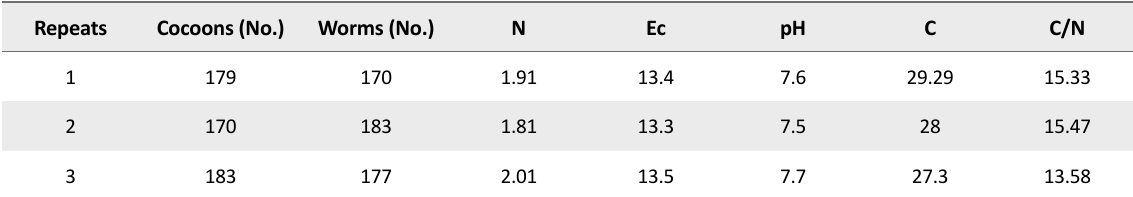
Table 1. Qualitative characteristics of the final vermicompost produced and the number of cocoons and earthworms in the base substrate (animal manure)